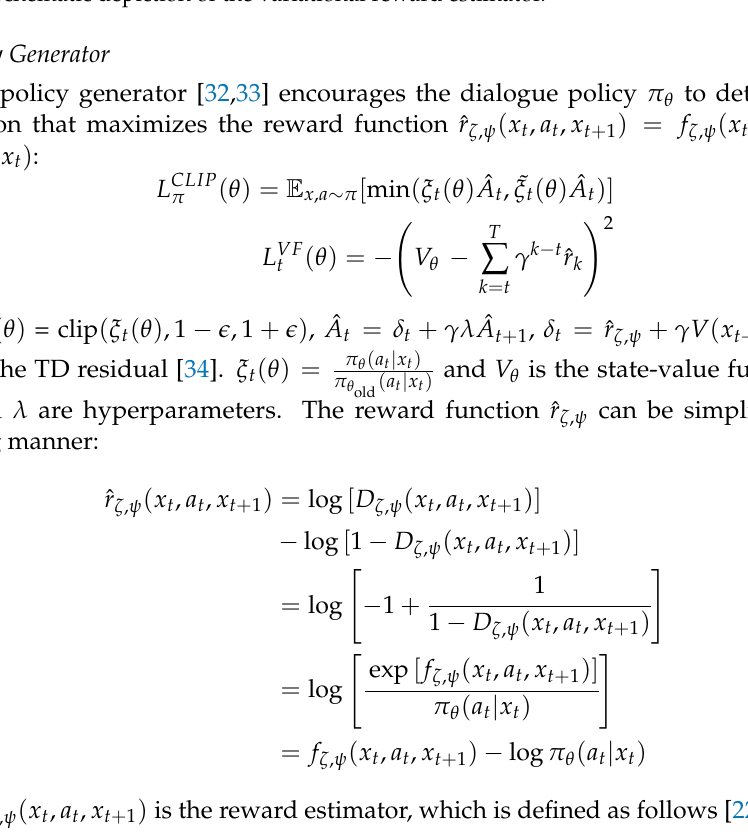
Figure 2. Schematic depiction of the variational reward